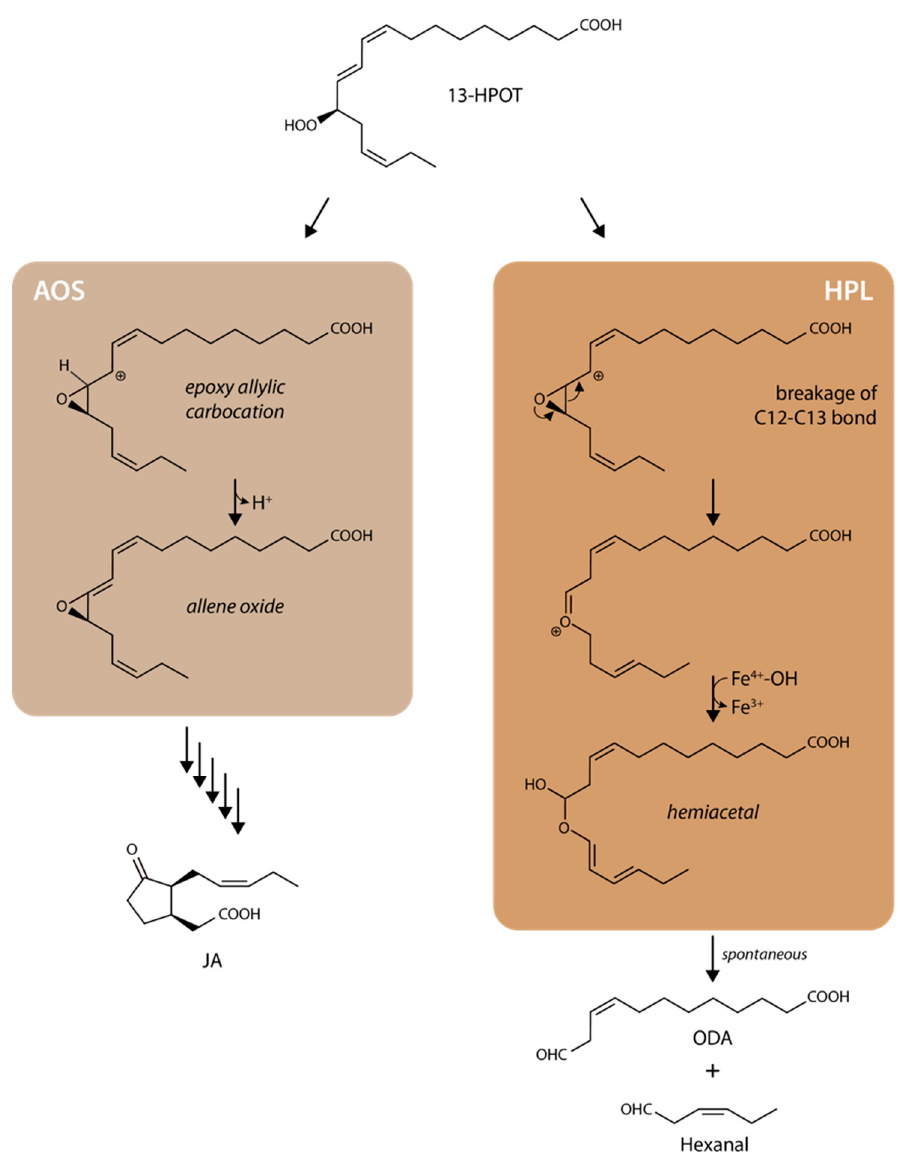
Figure 6. Reaction mechanism proposed on the basis of the bifunctional 8 R –LOX–AOS and 8 R –LOX– HPL enzymes from cyanobacteria and Capsella imbricate . Modified after Teder et al.